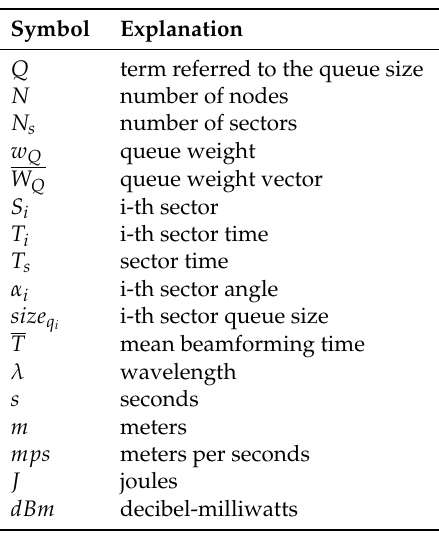
Table 3. List of symbols used in this